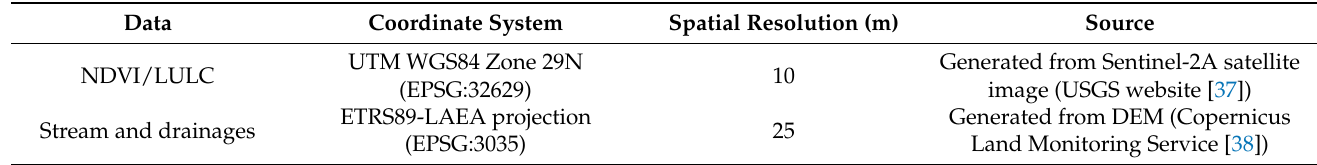
Table 1. Data sources adopted to produce the susceptibility map.